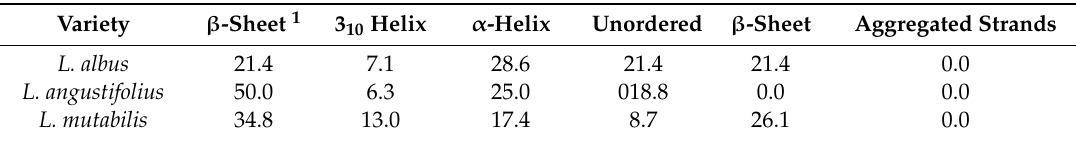
Table4. Proteinsecondarystructures(%)of Lupinus floursforthreedi ff erentvarieties: albus , angustifolius, and mutabilis .